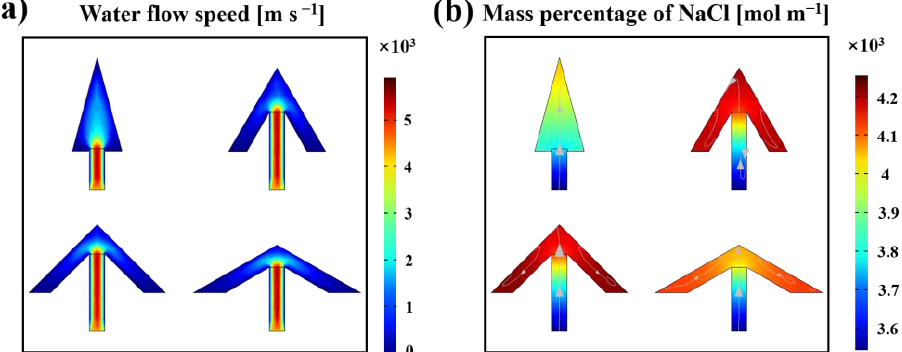
Figure 8. ( a ) Simulated water flow speed; ( b ) simulated salt concentration distribution(arrows is the direction of water flow).